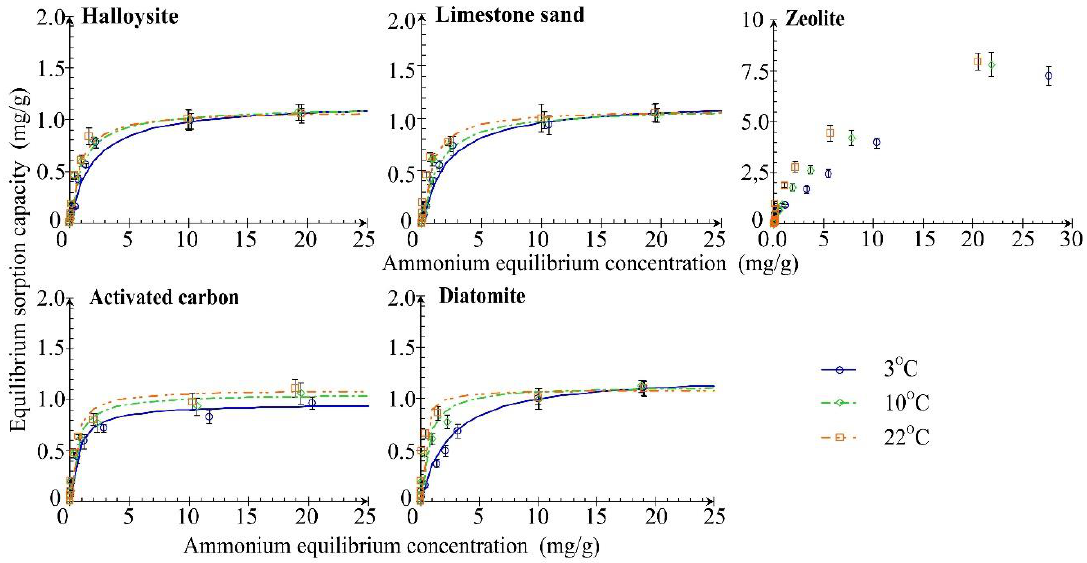
Figure 8. Adsorption isotherm of ammonium ions at 3 °C, 10 °C and 22 °C (error bars mark the standard deviation for n = 3; line—fitting of Langmuir isotherm).